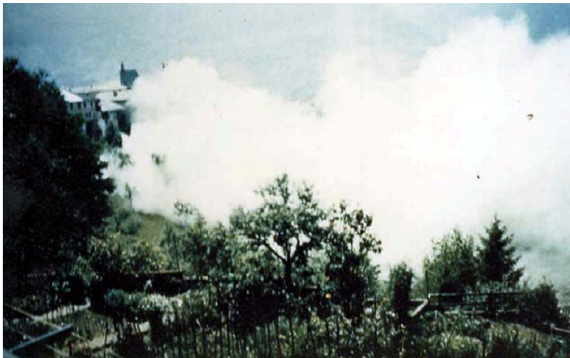
Fig. 12 – The shocking moment in which the mudflow, preceded by a white cloud, reached the urbanized areas on the valley bottom of Tesero (courtesy of Fondazione Stava 1985).